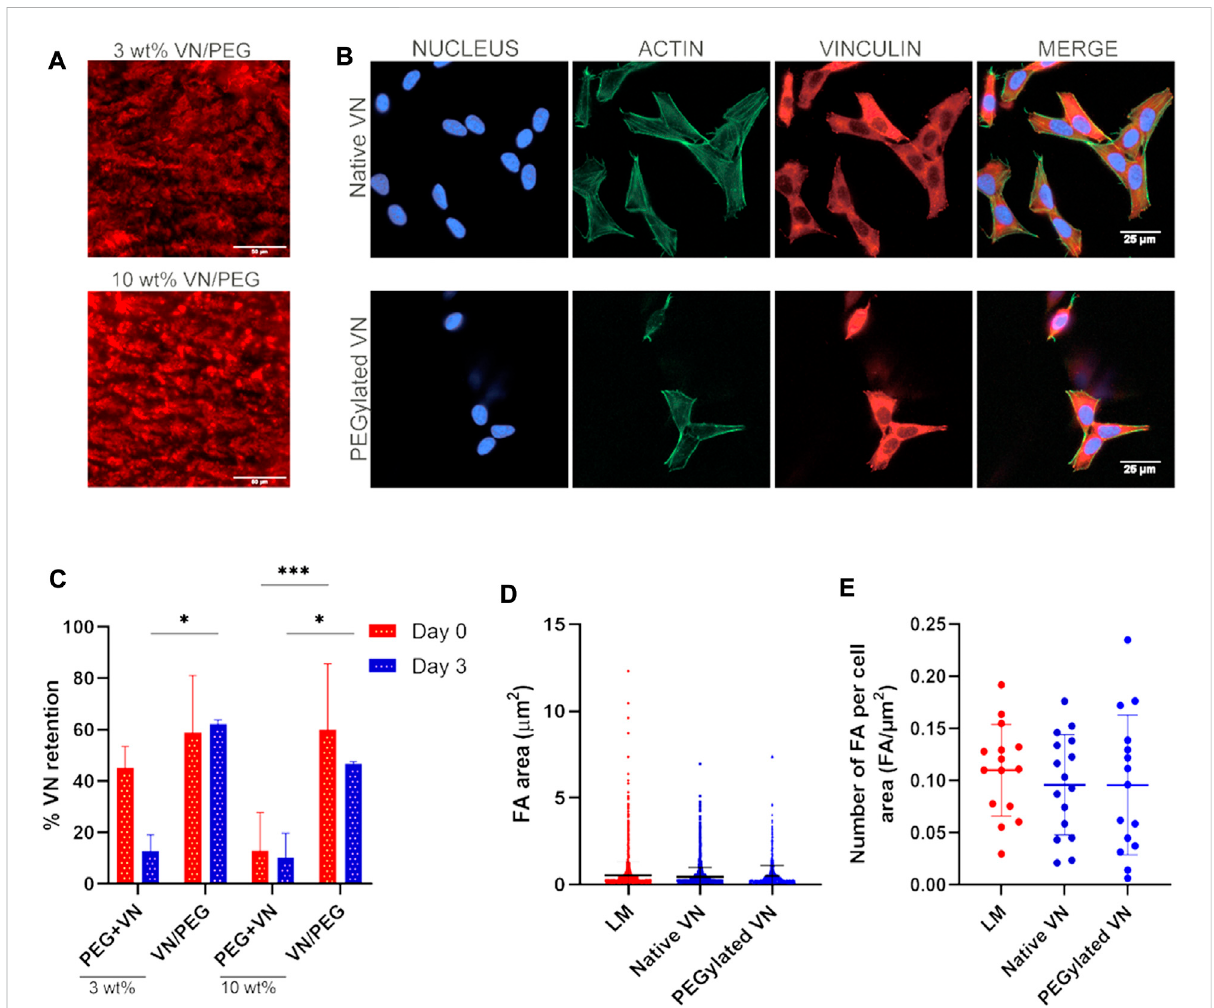
FIGURE 2 VN distribution and bioactivity after incorporation in the 3D hydrogel. (A) . Immuno fl uorescence images of VN distribution in 3 and 10 wt% VN/ PEG gelcryosections(scale bar50 µm).VNwas stainedwith aCy3secondaryantibody,shown inredintheimages. (B) .Representative fl uorescence images (nucleus in blue, actin in green and vinculin in red) of SK-N-BE (2) cells seeded on top of unmodi fi ed or PEGylated VN for 24 h (scale bar: 25 µm).InsetsofFAimagesareshowninSupplementaryFigureS3. (C) .Immuno fl uorescenceimagesofVNdistributionin3and10 wt%VN/PEG gel cryosections were quanti fi ed by QuPath 0.3.2 to calculate VN retention after 3 days. (D) . The area of the focal adhesions was found comparable between all conditions. (E) . The same trend was observed after analysis focal adhesion density. For each experiment, 15 images (3 replicates, fi ve images each) were analyzed per sample